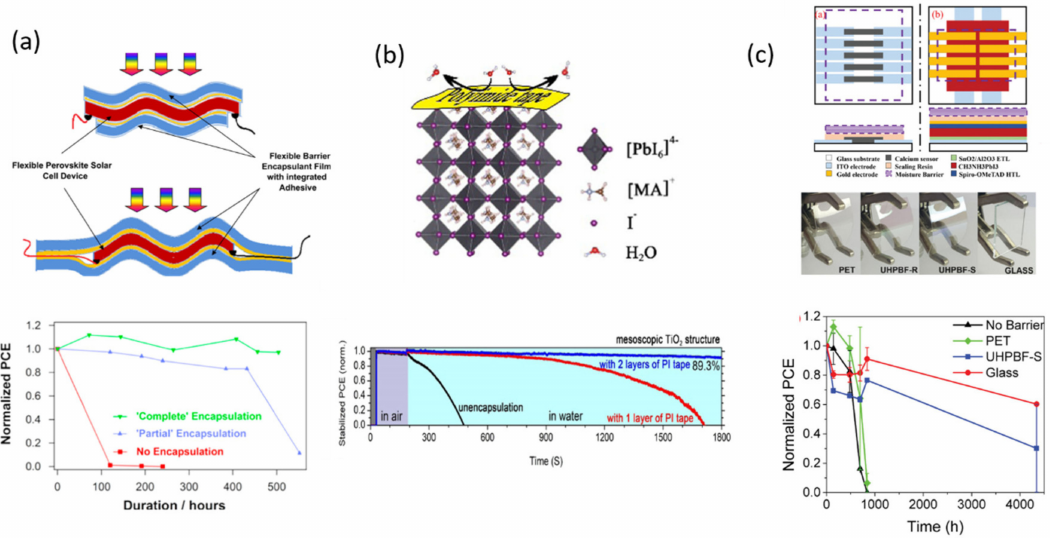
Figure 4. Polymer encapsulation methods. ( a ) Scheme of a flexible indium-doped, zinc oxide-coated polyethylene terephthalate (IZO-PET) barrier encapsulant film with integrated adhesive. Reproduced with permission of Ref. [78]. ( b ) Scheme of adhesive encapsulation by employing commercial polyimide tape on perovskite solar cells and its corresponding normalized PCE during stability test. Reproduced with permission of Ref. [79]. ( c ) Layouts used to measure degradation of calcium sensors ( left ) and perovskite solar cells (PSC, right ). Different barriers used, including PET, glass, and ultra-high permeation barrier films (UHPBF). Reproduced with permission of Ref.